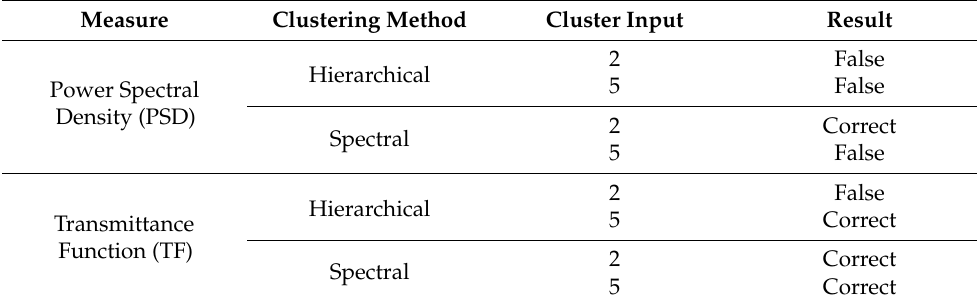
Figure 12. Spectral clustering using TF. Input cluster = 2 ( up ), input cluster = 5 ( down ). Table 3. Results Table 3. Results summary.